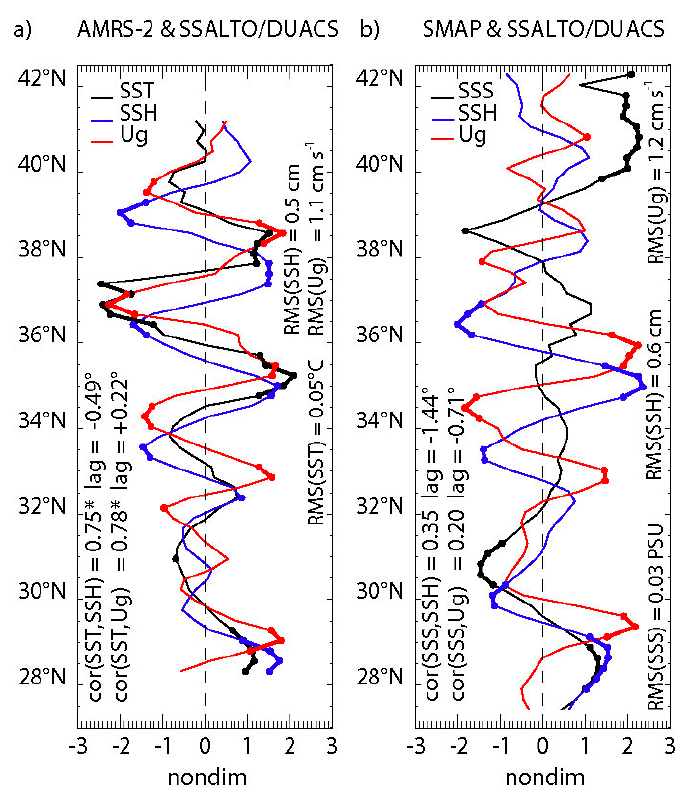
Figure 11. Same as Figure 6a,b, except averaged within the tilted solid box on Figure 2e. The stars (*) indicate when the correlation is significant at the 5% level (see Table S4).